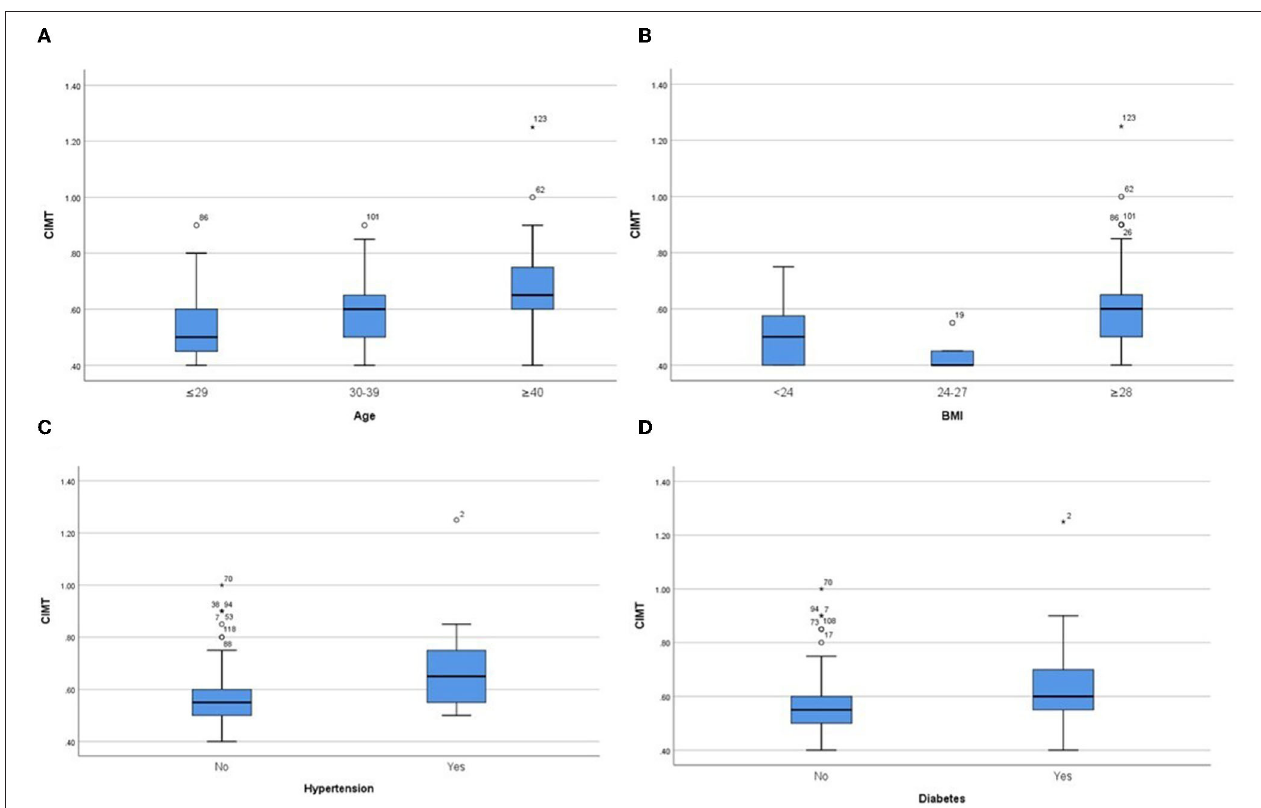
FIGURE 2 | Comparison of CIMT values in subgroups of different ages (A) , different BMIs (B) , hypertension (C) and diabetes (D) . P < 0.05 in all subgroups.